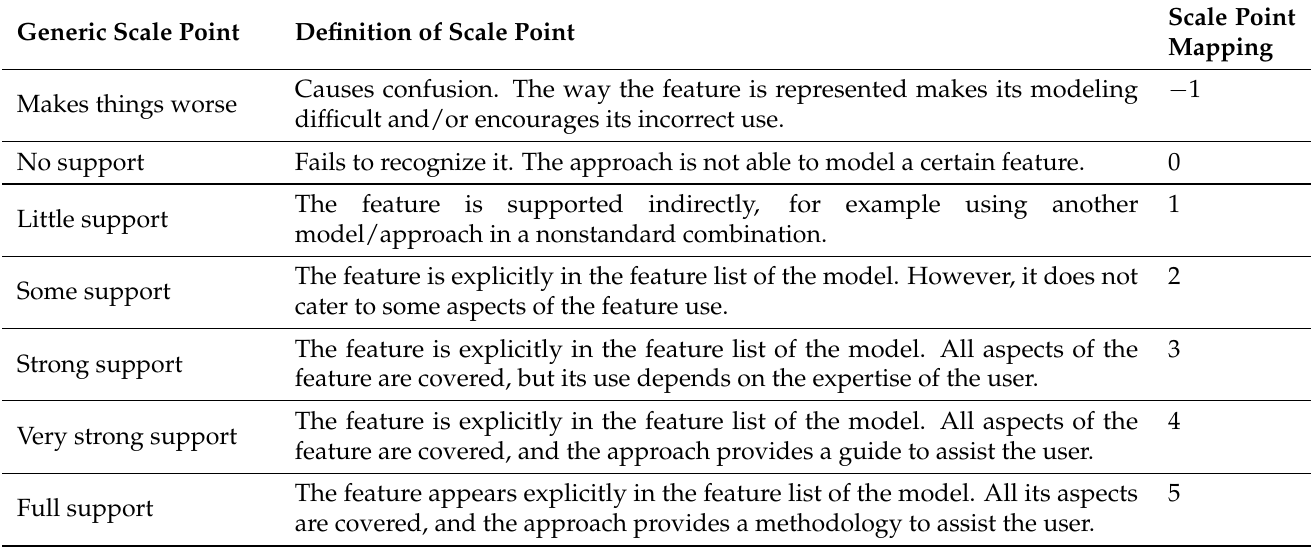
Table 3. Judgment scale to assess tool support for a